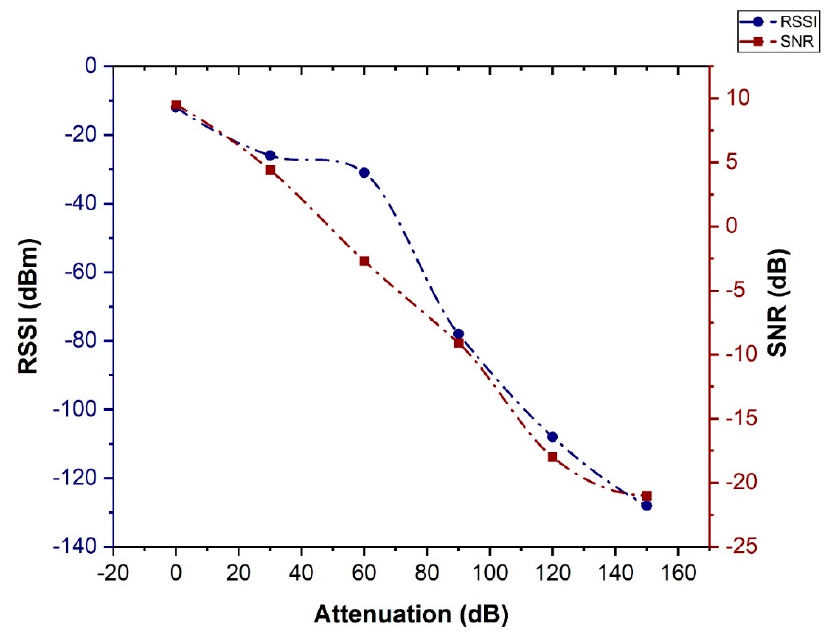
Figure 12. Relationship of RSSI and SNR at 0 − 150 dB attenuation levels with a step of 30 dB. As shown in the above experiment, it is observed that we received the signal at 150 dB, which is the maximum distance of our slant range. This confirms that the spacecraft at a minimum look angle will be able to transmit data.